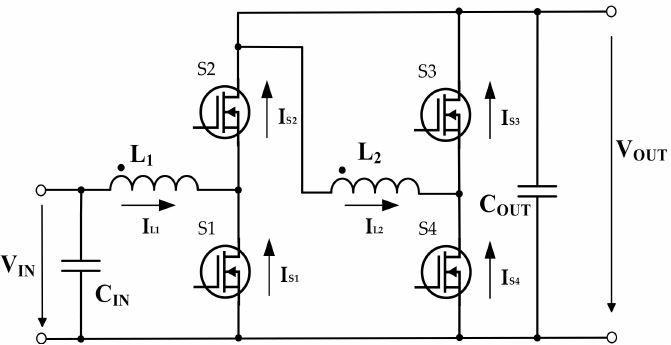
Figure 4. Circuit schematic of non-modular interleaved bidirectional buck-boost (Bi-BB)